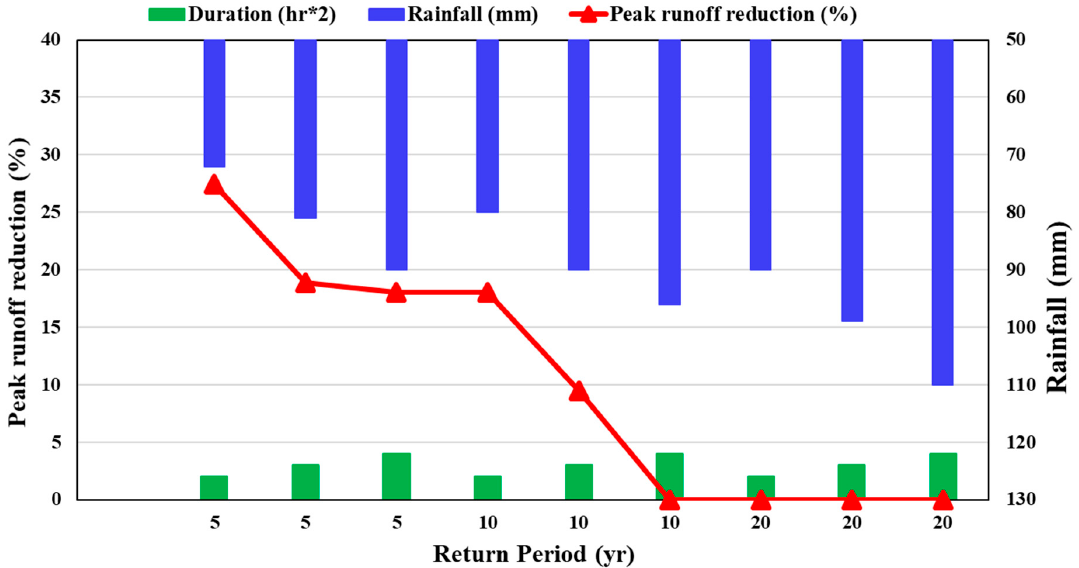
Figure 11. Peak runoff reduction for the selected rainfall scenarios.